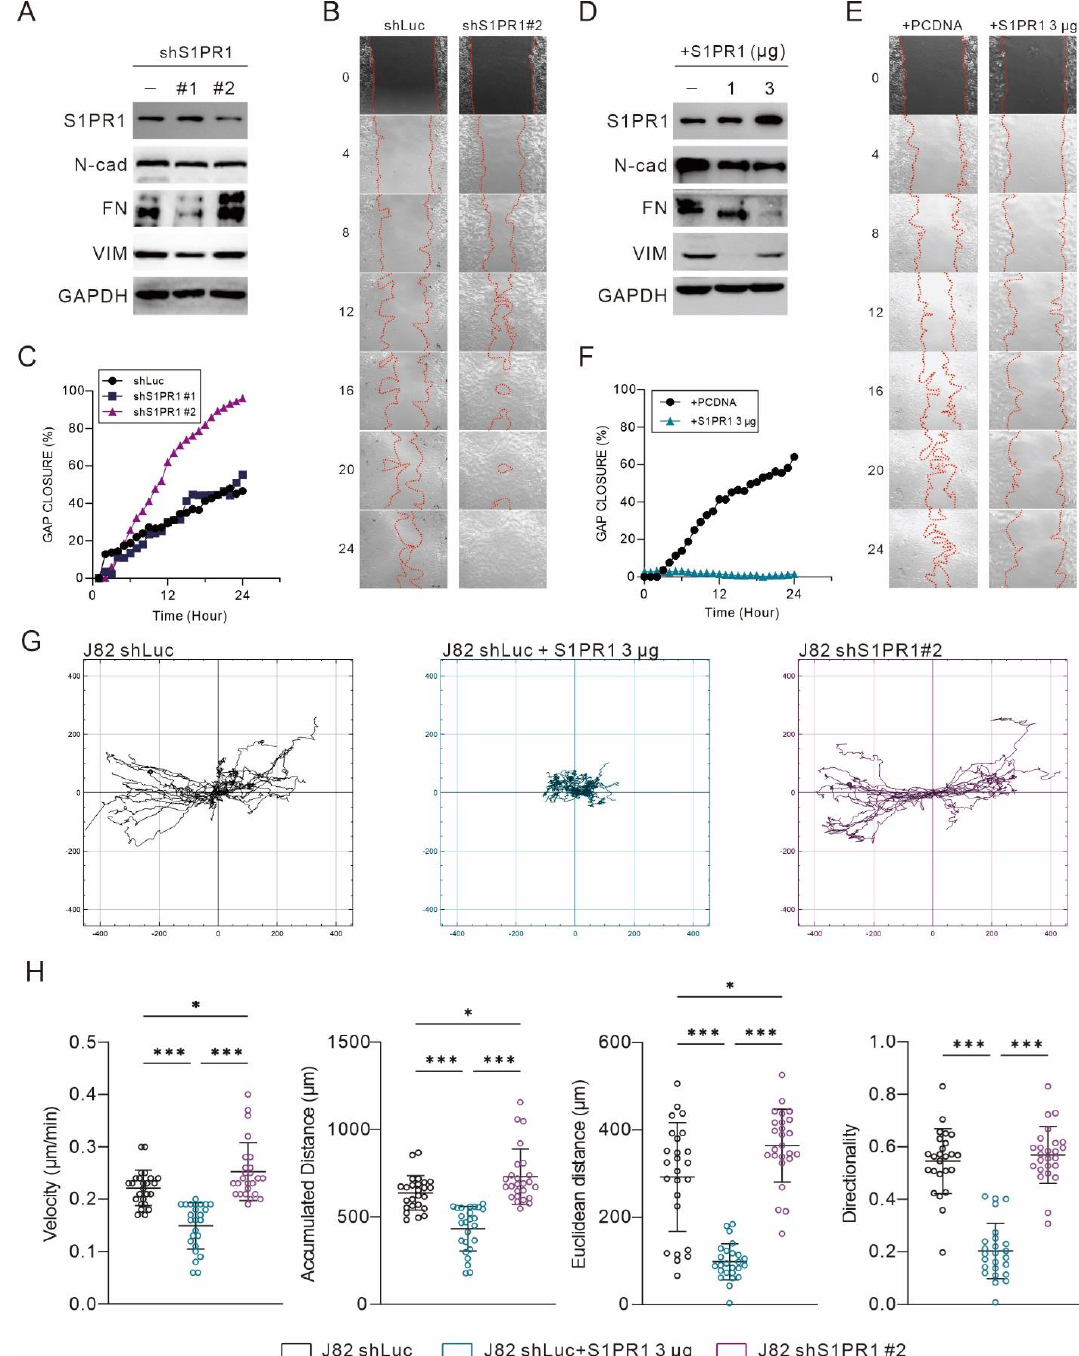
Figure 6. Negative correlation between S1PR1 expression and bladder cancer cell motility. ( A , D ) Western blot demonstrating the efficacy of S1PR1 expression manipulation and matching EMT marker expression. ( B , E ) Twenty-four hour live cell image tracking showed the progressions in gap area at multiple time points. ( C , F ) Gap closure (%) presents the effect of manipulating S1PR1 expression on wound healing. ( G ) Migration tracking plot for J82 shLuc, shLuc + S1PR1 (3 µ g), and J82 sh S1PR1 #2. Cell migration was tracked for 48 h after the wound healing assay started, with cell positions determined every 30 min. In each panel, the center indicates the starting point. ( H ) Statistical analysis of the J82 tracking cell migration rate, distance, and directionality, with lines showing mean and standard deviation. J82 shLuc (n = 29); J82 + S1PR1 3 µ g (n = 30); J82 sh S1PR1 #2 (n = 30). * p < 0.05, *** p < 0.001. (VIM: vimentin, GAPDH: glyceraldehyde 3 phosphate dehydrogenase) (for uncropped Western Blot images, please refer to Supplementary File